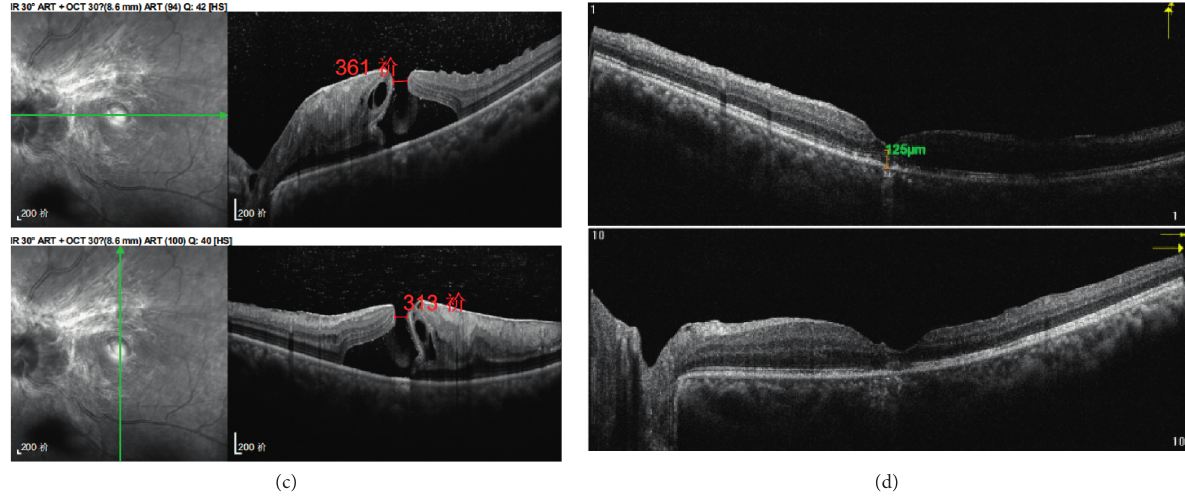
Figure 2: Left eye of a 31-year-old man with vasoproliferative tumor of the retina (Case 10): Fundus photograph: (a) before treatments, the macular hole with the size of 1/2 optic disc diameter (PD) could be seen in the macula. A yellow globular pale mass sized 5 PD was located in the inferior temporal periphery. The mass was connected with feeder vessels and was surrounded by laser spots. (b) Three months after cryotherapy, the tumor was depauperate with the occluded feeder vessels. Spectral-domain optical coherence tomography (SD-OCT): (c) before treatments, the epimacular membrane and an IV macular hole with a size of 361 μ m ∗ 313 μ m could be seen. The best-corrected visual acuity (BCVA) was 1 logMAR. (d) Three months after treatments, the morphology of the macula was improved. The central retinal thickness was 125 μ m. The BCVA was 0.8